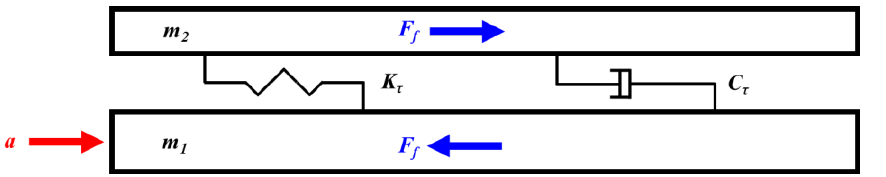
Figure 6. Equivalent contact model for reticle and chuck.